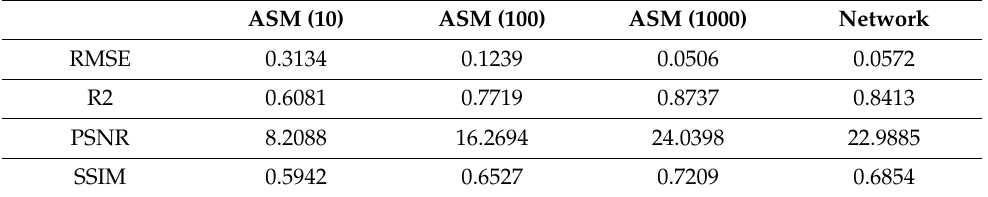
Table 3. Performance evaluation of reconstruction results based on complex